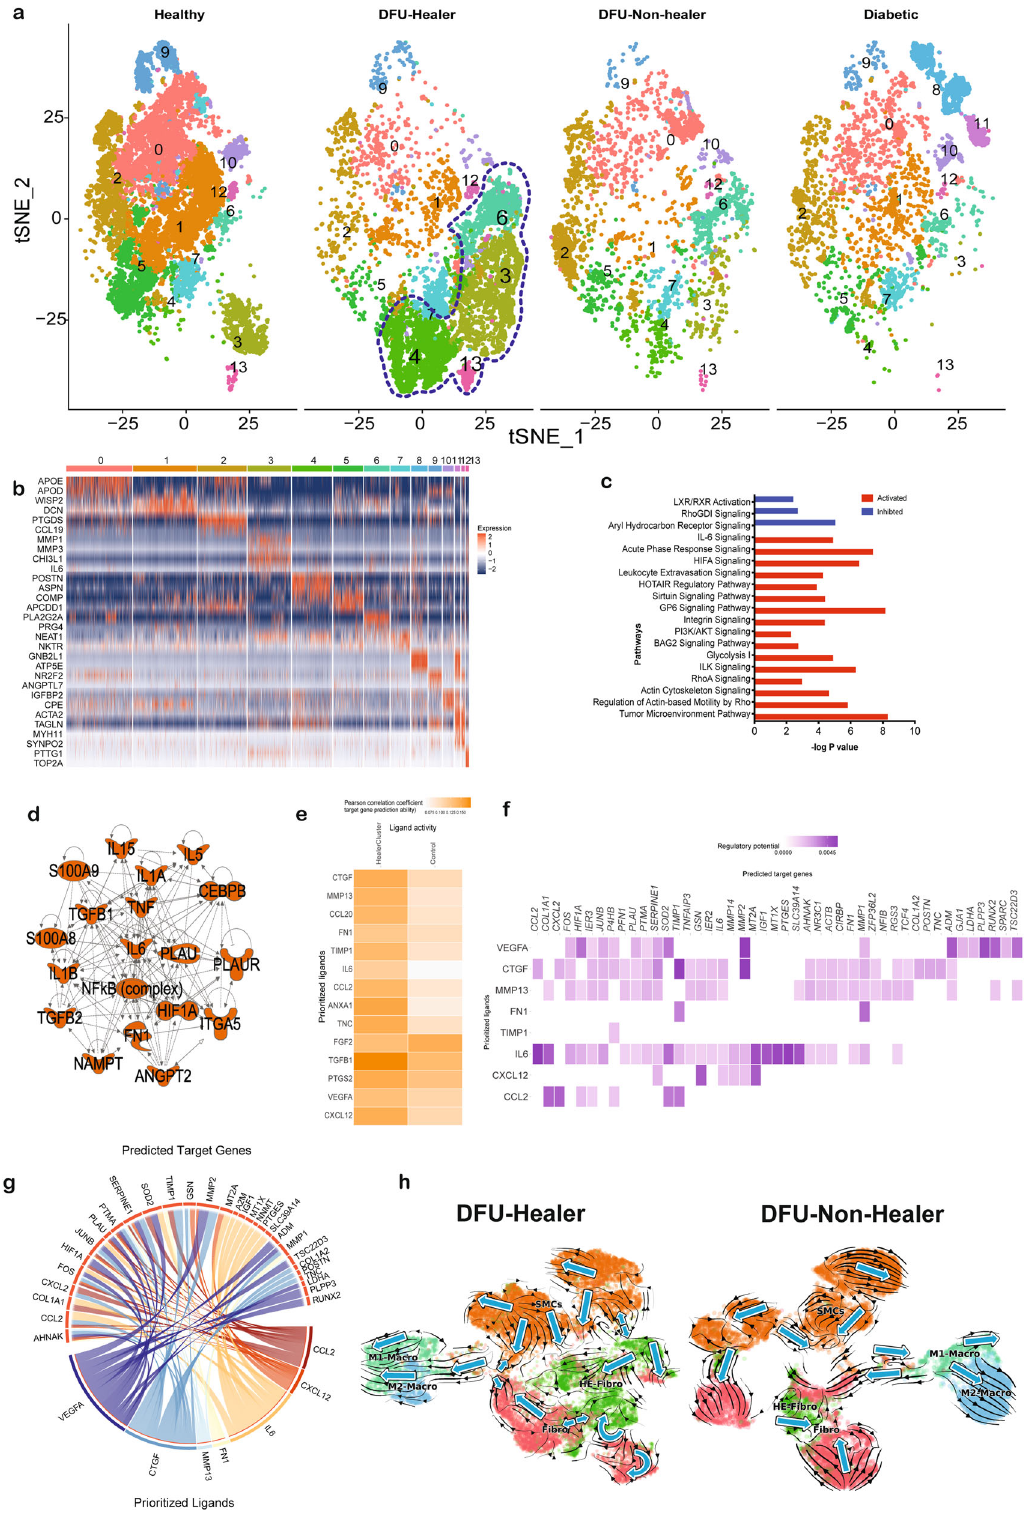
A heatmap displaying the connection between these key ligands that are expressed by HE-Fibro sub-cluster 3 (rows) and marker genes for the HE-Fibro sub-clusters (3, 4, 6, and 13) (columns) is shown in Fig. 5f and Supplementary Fig. 12. For example, CCL2 overexpression in the “ receiver ” HE-Fibro sub-clusters can be strongly predicted by the presence of IL6 in the “ sender ” HE- Fibro sub-cluster, indicating possible molecular interaction